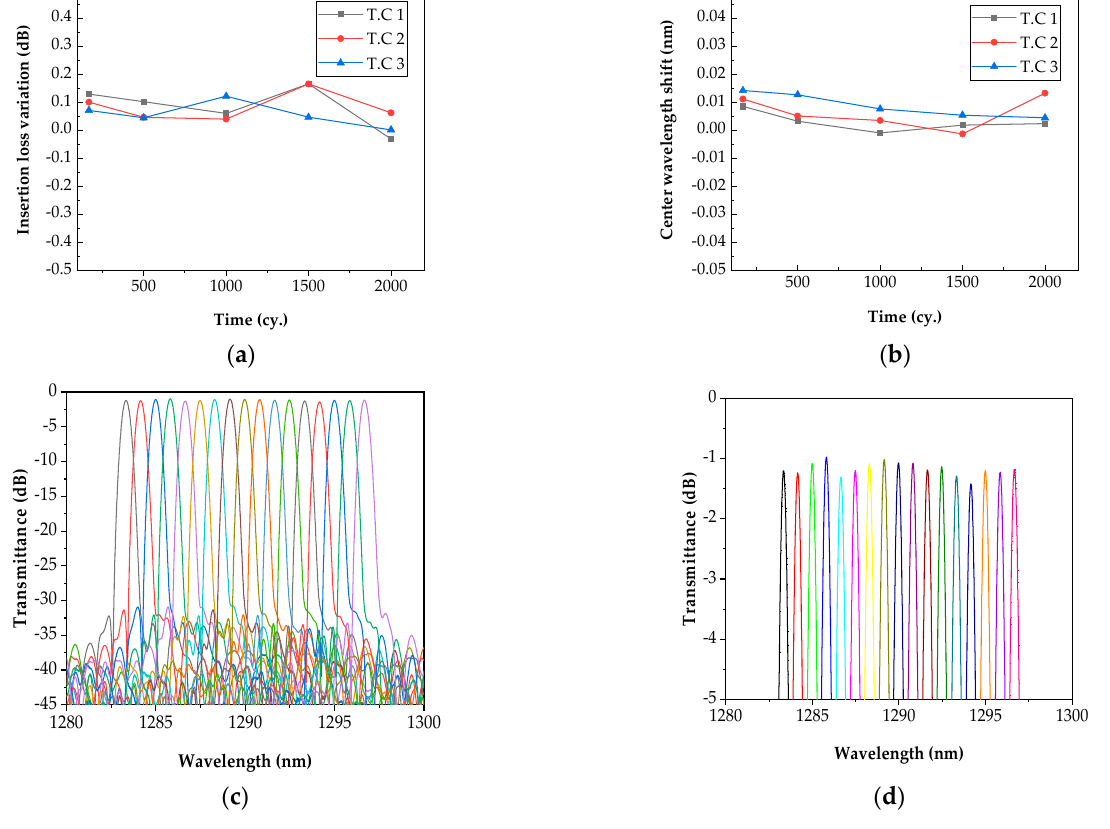
Figure 6. Average results of 17 channels in three AAWG modules after temperature cycling testing (T.C.): ( a ) IL deviation; ( b ) C.W. shift; ( c ) Spectrum (T. C. 1); ( d ) Zoom in spectrum around 0 to − 5 dB transmission (T. C. 1).